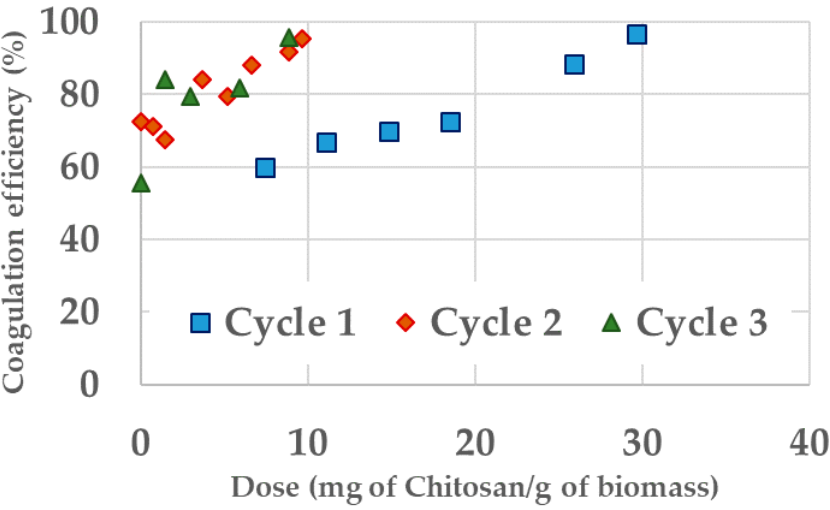
Figure A7. Evolution of the nitrate, phosphate, and sulfate concentrations during the semi-contin- uous test for HWWC.